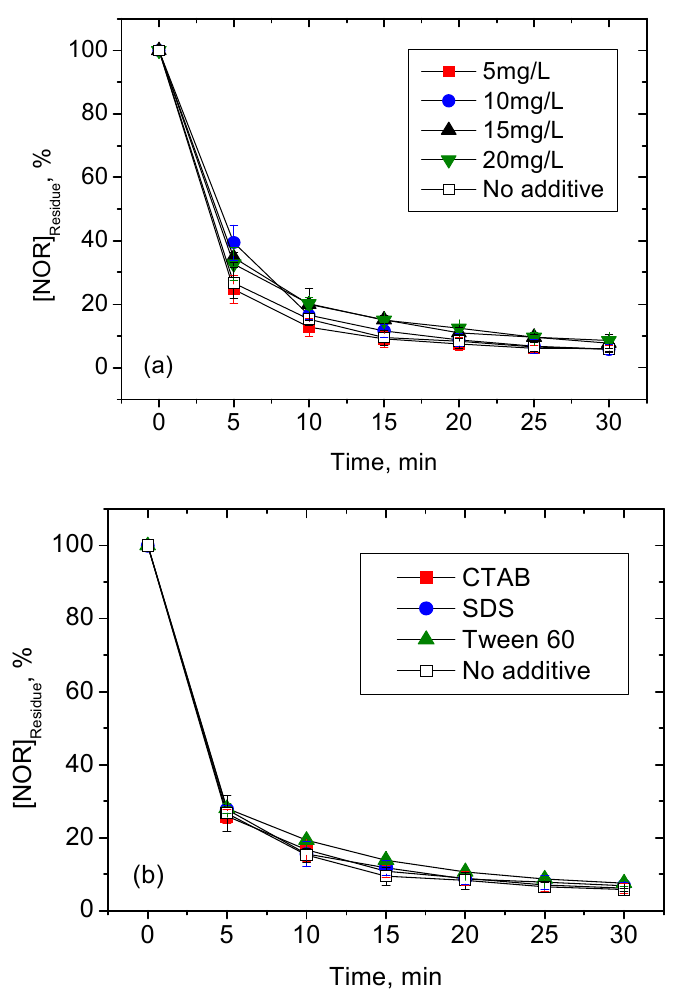
Figure 4. ( a ) Effect of humic acid concentration on the degradation of NOR by the MW/UV process and ( b ) Effects of different surfactants on the degradation of NOR by the MW/UV process. (Experimental conditions: microwave power = 500 W, UV light intensity = 31.8 mW/cm 2 , maximum wavelength = 254 nm, [NOR] = 5 mg/L, and [surfactant]: 5 mg/L).